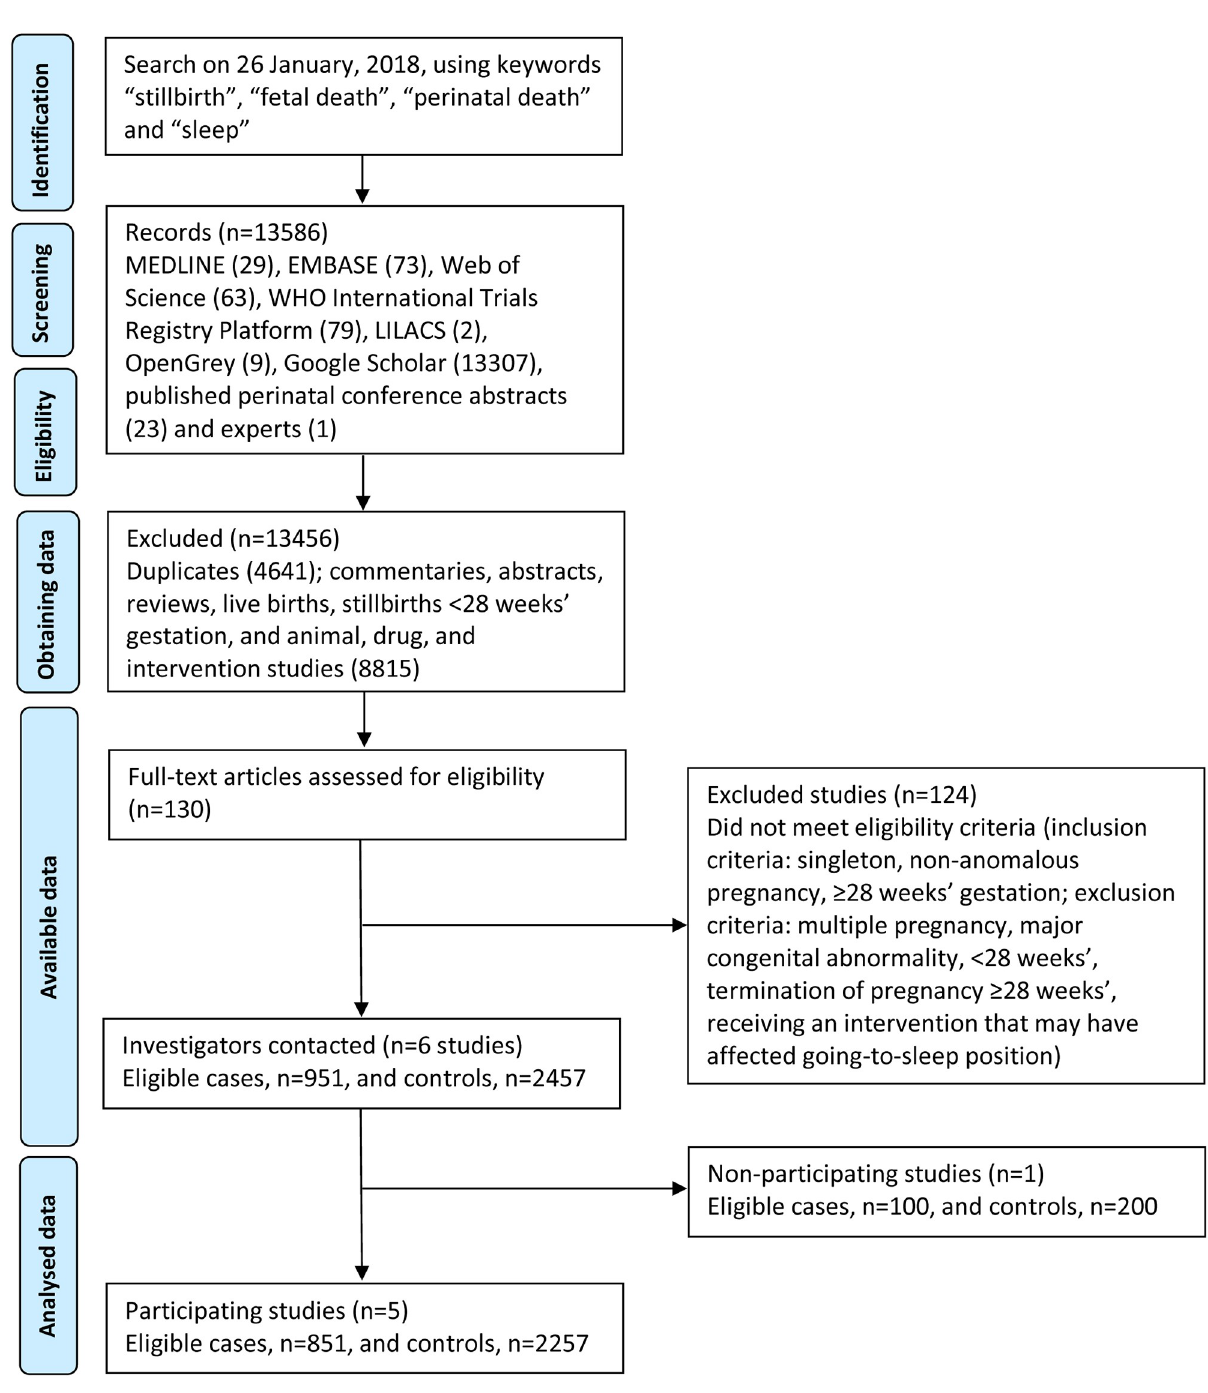
Fig 1. PRISMA study population flow chart. Adapted from EClinicalMedicine, Vol 10, Authors: Cronin, RS., Li, M., Thompson, JMD., Gordon, A., Raynes-Greenow, CH., Heazell, AEP., Stacey, T., Culling, VM., Bowring, V., Anderson, NH., O’Brien, LM., Mitchell, EA., Askie, LM., McCowan, LME, An Individual Participant Data Meta-analysis of Maternal Going-to-Sleep Position, Interactions with Fetal Vulnerability, and the Risk of Late Stillbirth, Pages 49–57., Copyright (2019), with permission from Elsevier. https://doi.org/10.1371/journal.pone.0230861.g001 PLOS ONE | https://doi.org/10.1371/journal.pone.0230861 March 26,